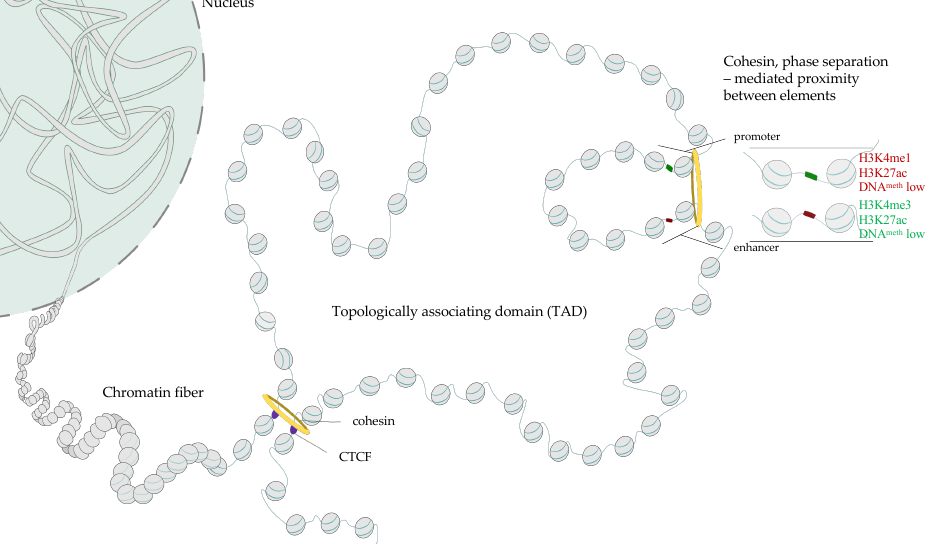
Figure 1. Chromatin 3D structure in the cell in relation to transcriptional regulation. Promoter- enhancer loops form within the context of the topologically associating domains (TADs), which arise as a consequence of the action of the cohesin complex. The binding of CTCF blocks the displacement of the cohesin ring thereby defining the location of the TADs boundaries. Active promoters and enhancers are devoid of DNA methylation. The two classes of elements display a specific histone modification signature featuring high levels of H3K27ac (both enhancer and promoters) and unique pattern of H3K4me3 modification (promoters being highly enriched and enhancers displaying non- detectable or low level of this modification). H3K4me1 is particularly enriched at active and poised enhancers. When active, promoters and enhancers can often display an increased spatial proximity in the cell